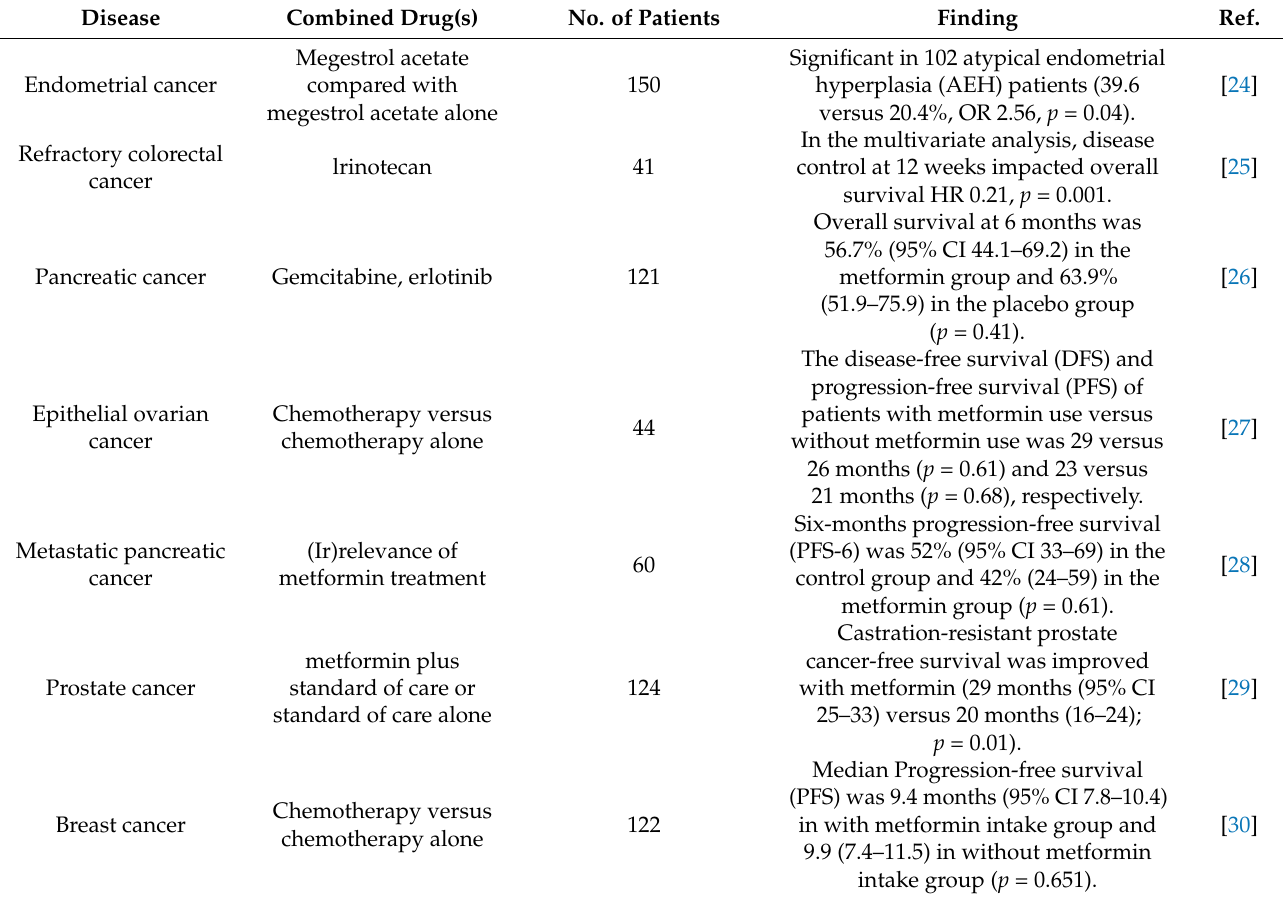
Table 1. Clinical studies of agents in combination with